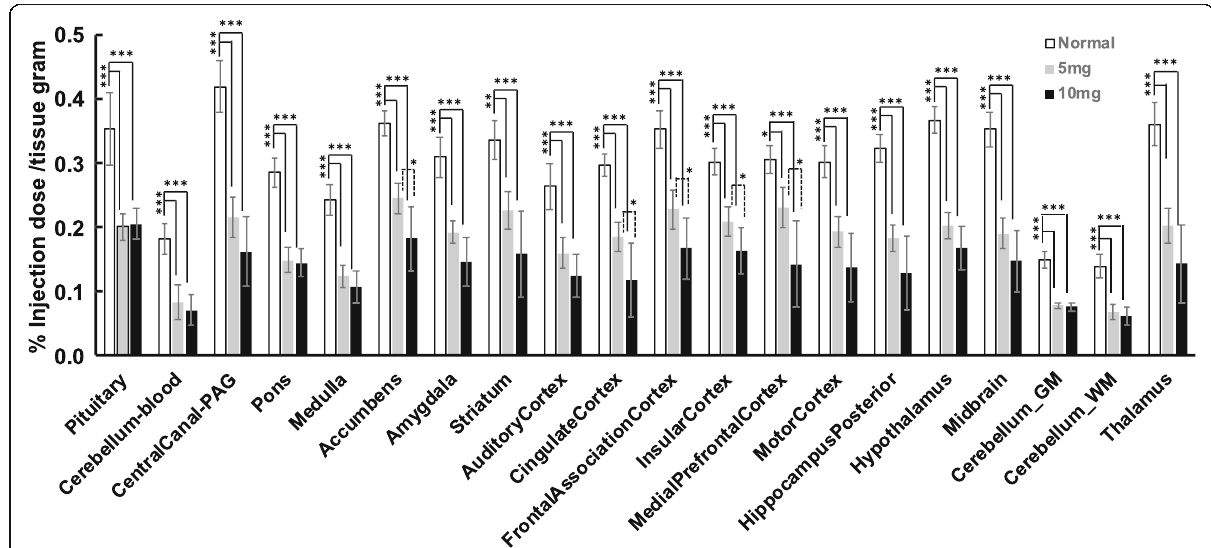
Fig. 2 The accumulation of 4-[ 18 F]ADAM, showing SERT availability, tended to decrease in most brain regions with increasing METH dose in rats. The higher dose of METH (10 mg/kg) caused a dramatic reduction of SERT availability. The accumulated radioactivity is expressed as a percentage of the injection dose/tissue gram (%ID/g) as the mean ± SD of 6 – 8 rats per group. * p < 0.05, ** p < 0.01, and *** p < 0.001 compared to the control